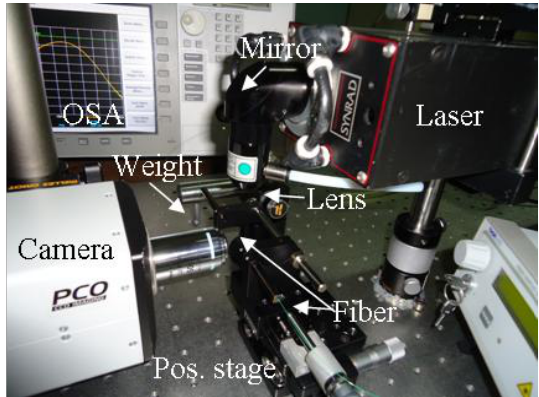
laser writing a LPFG on a Corning SMF-28 2